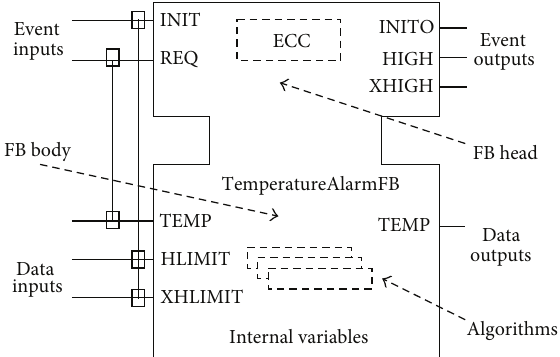
Figure 4: Graphical representation of the FB-type design level construct.